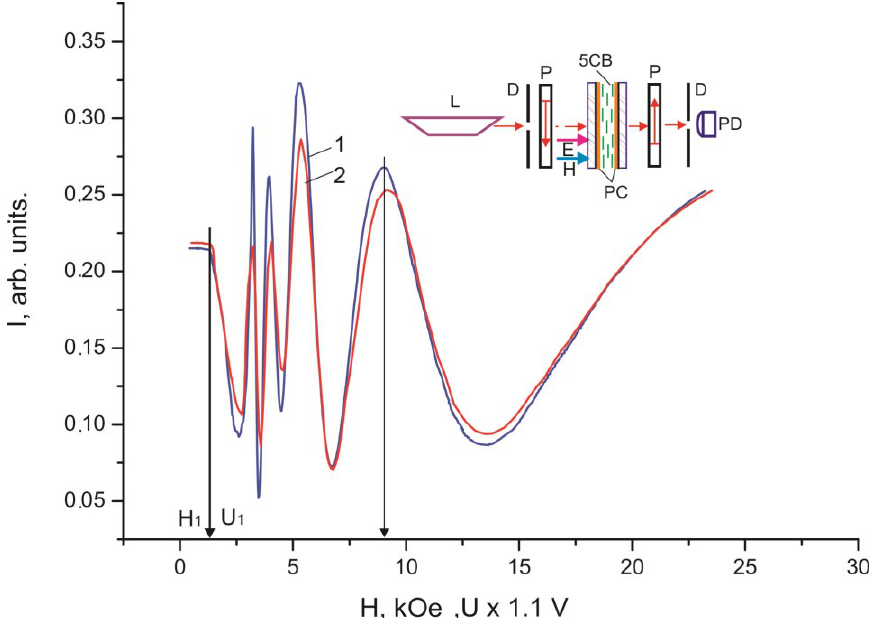
Figure 6. Dependences of intensity I of monochromatic light passed through the 30 µm thick planar 5CB layer formed in magnetic field H * on magnetic field H (curve 1) and voltage U (curve 2) in crossed